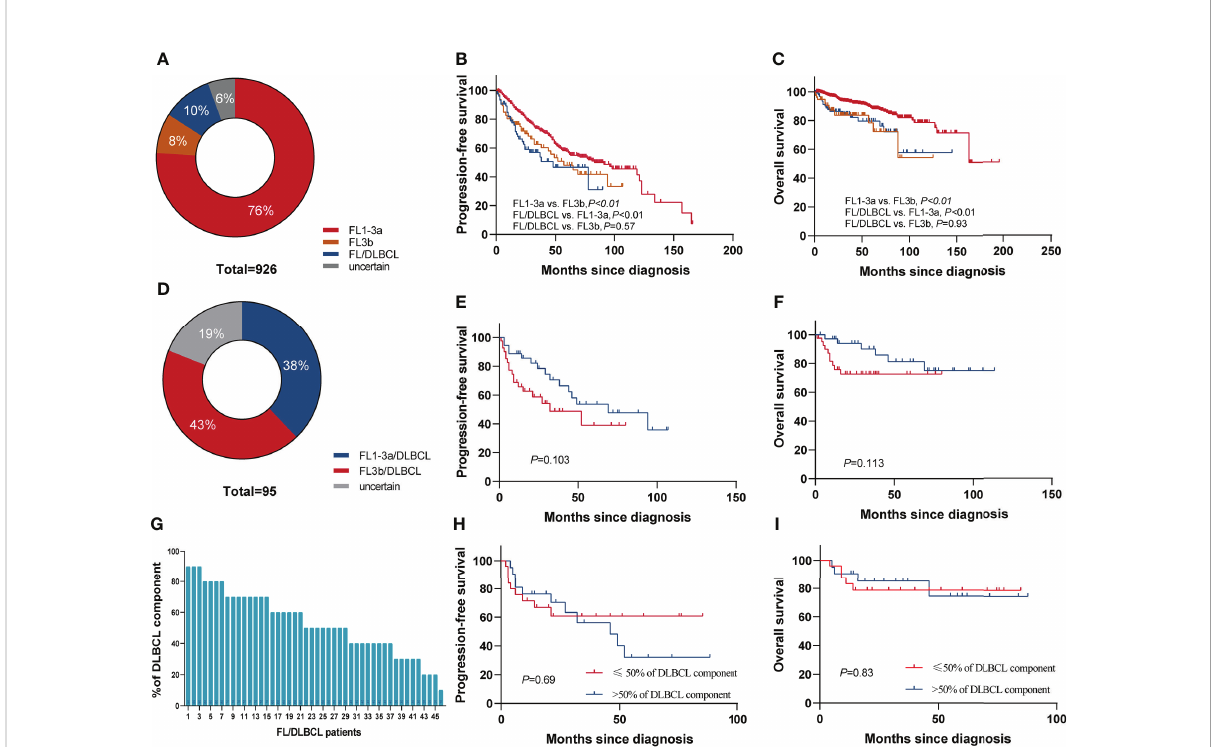
FIGURE 2 Survival based on histological grade of FL. (A) Pie chart showing the proportion of different histological grades of FL. Kaplan – Meier curves of (B) PFS and (C) OS for FL grade 1 – 3a, grade 3b, and FL/DLBCL groups. (D) Pie chart showing the proportion of FL1 – 3a/DLBCL and FL3b/DLBCL. Kaplan – Meier curves of (E) PFS and (F) OS for FL1 – 3a/DLBCL and FL3b/DLBCL. (G) The amount of the DLBCL component ranged from 5% to 90%. (H) PFS and (I) OS according to the percentage of DLBCL component in FL/DLBCL